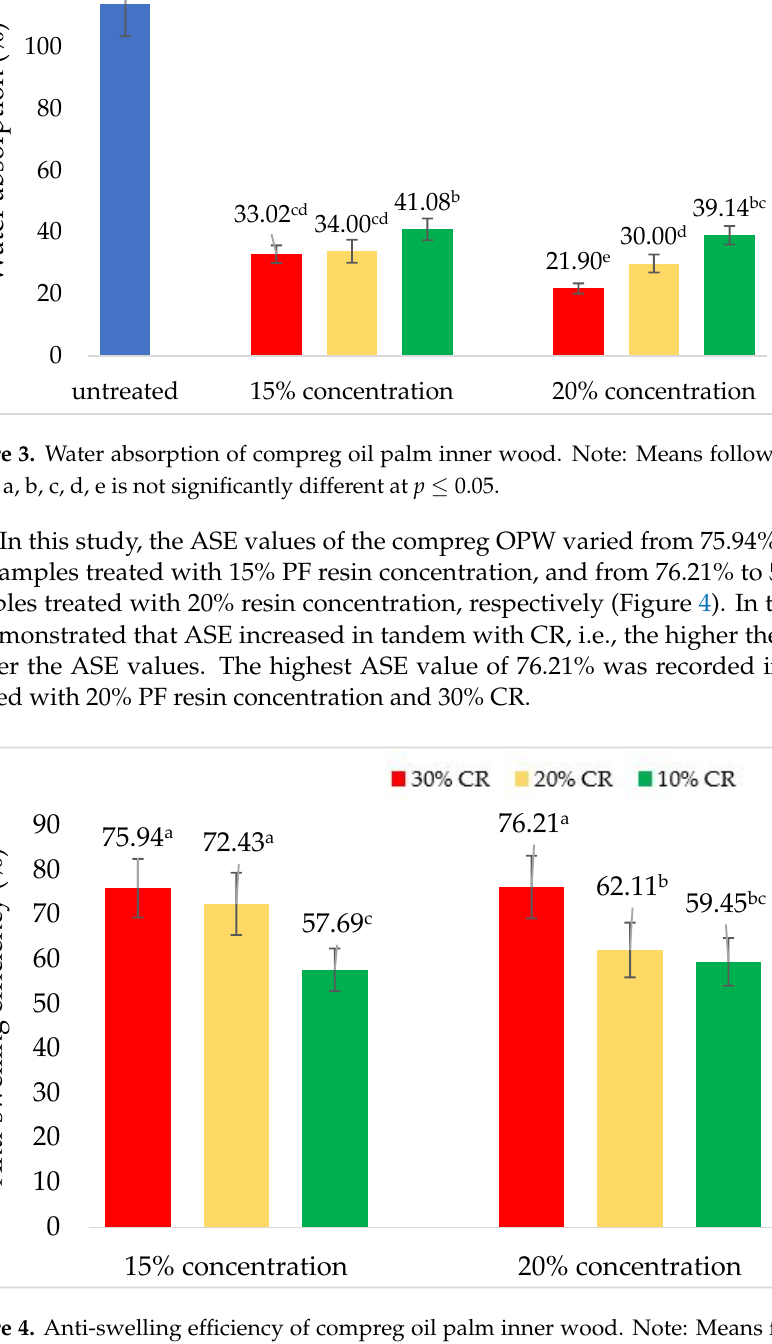
7 of 15 Figure 2. Thickness swelling of compreg oil palm inner wood. Note: Means followed by the same letter a, b, c, d, e is not significantly different at p ≤ 0.05 As seen in Figure 3, the increased PF resin concentrations from 15% to 20%, and com- pression ratios resulted in reduced WA values of the treated OPW. The untreated OPW